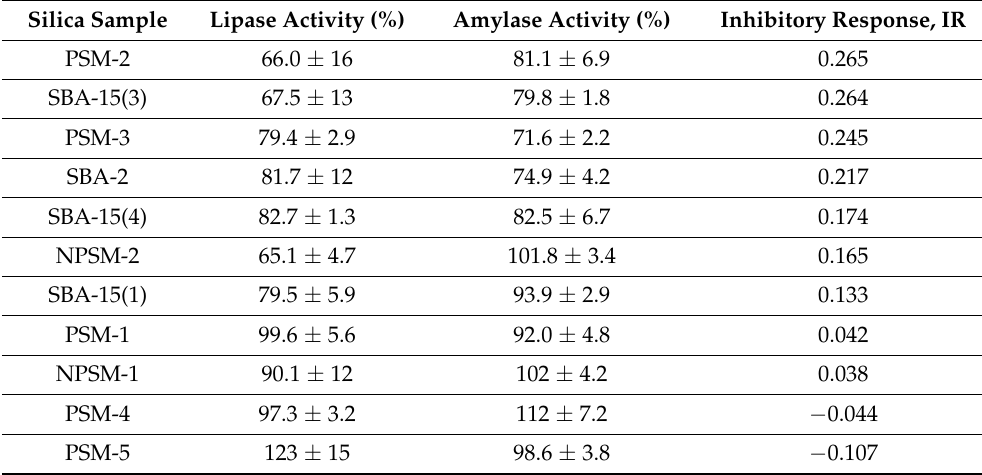
Table 2. Enzyme activities and the corresponding Inhibitory Response (IR) when exposed to porous silica samples. Porous silica samples have been ordered from greatest to least enzyme inhibitory